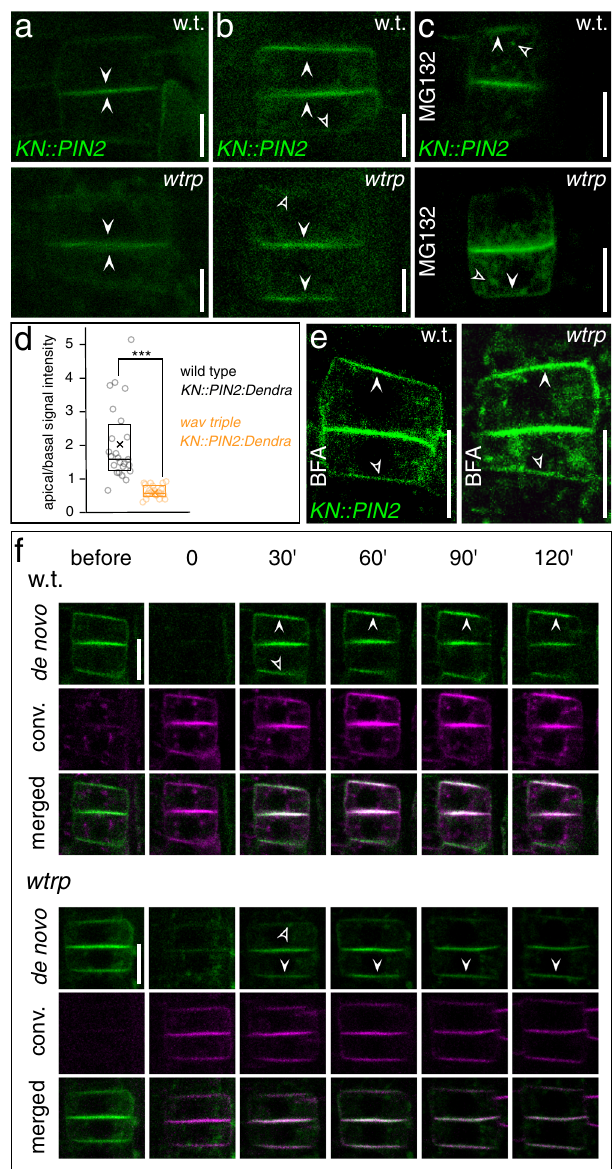
were con fi rmed by two rounds of genotyping. DR5rev:3XVENUS-N7 22 ;